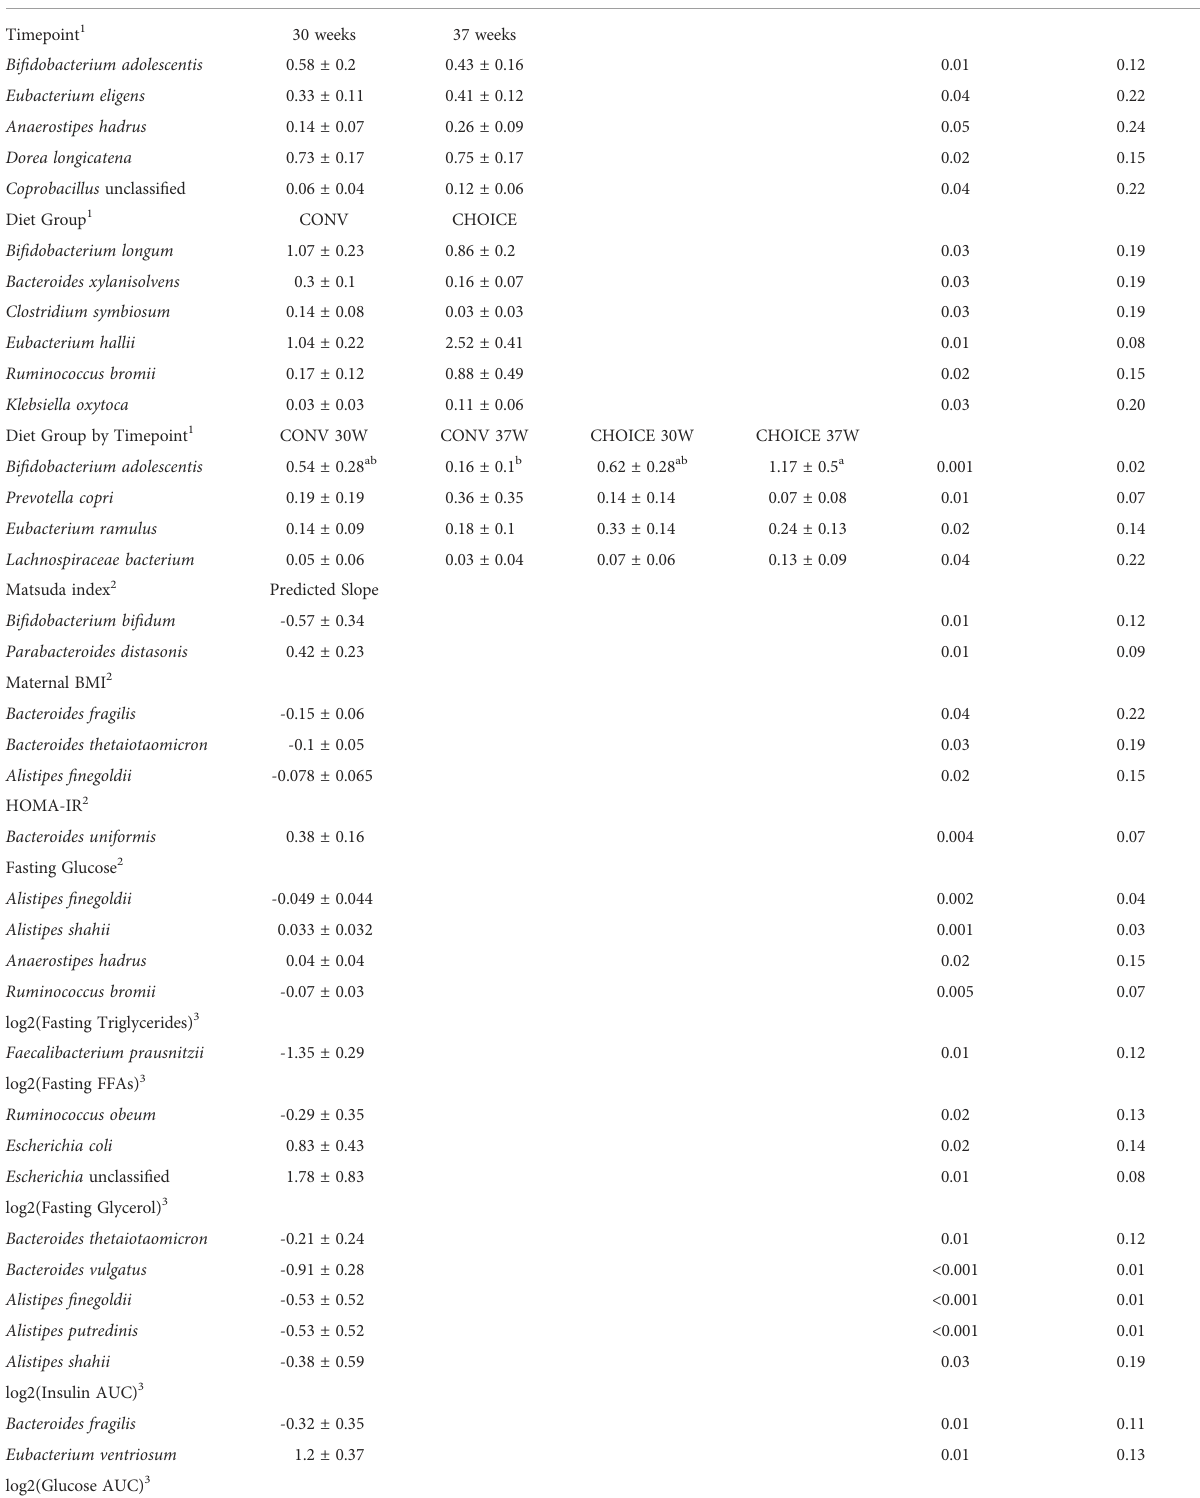
TABLE 4 Variables associated with maternal species – level taxa determined by negative binomial